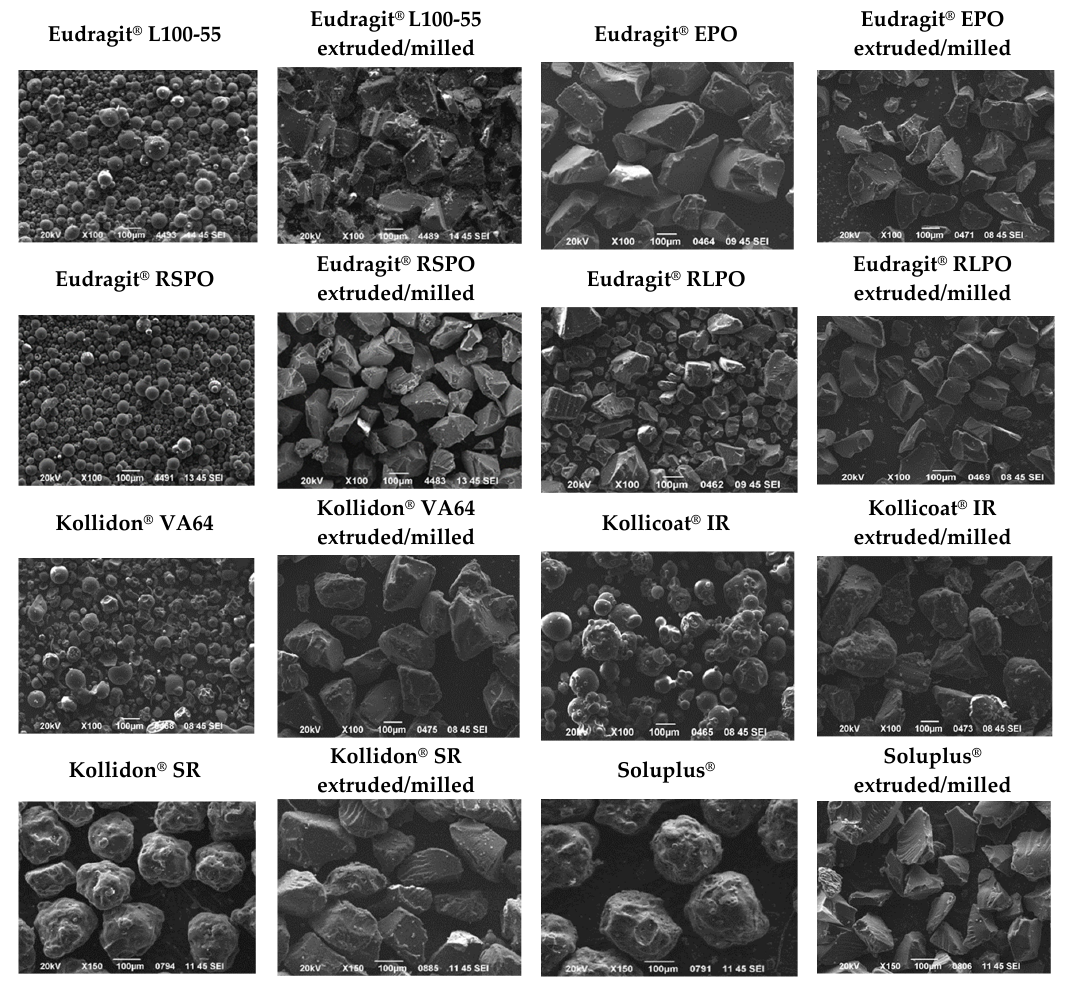
Figure 2. SEM microphotographs of the particles of neat and extruded experimental polymeric